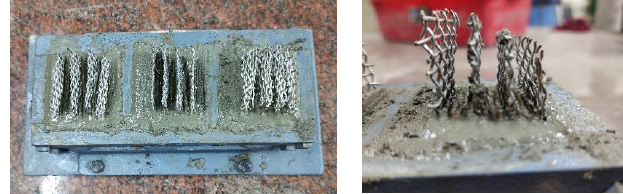
Figure 4. Hybrid fibre added mortar cube specimen placed with steel mesh.